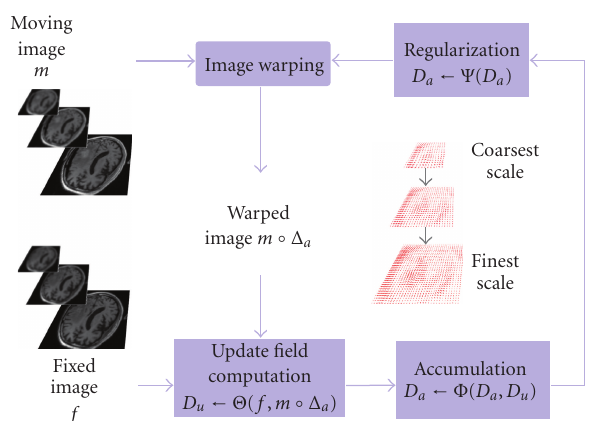
Figure 3: The nonparametric registration pipeline is composed of 3 main operations ( Θ , Φ , and Ψ ) and the warping of the moving image. Those operations are performed from coarse to fine scales. At each scale, the process is applied iteratively, until it reaches a stopping